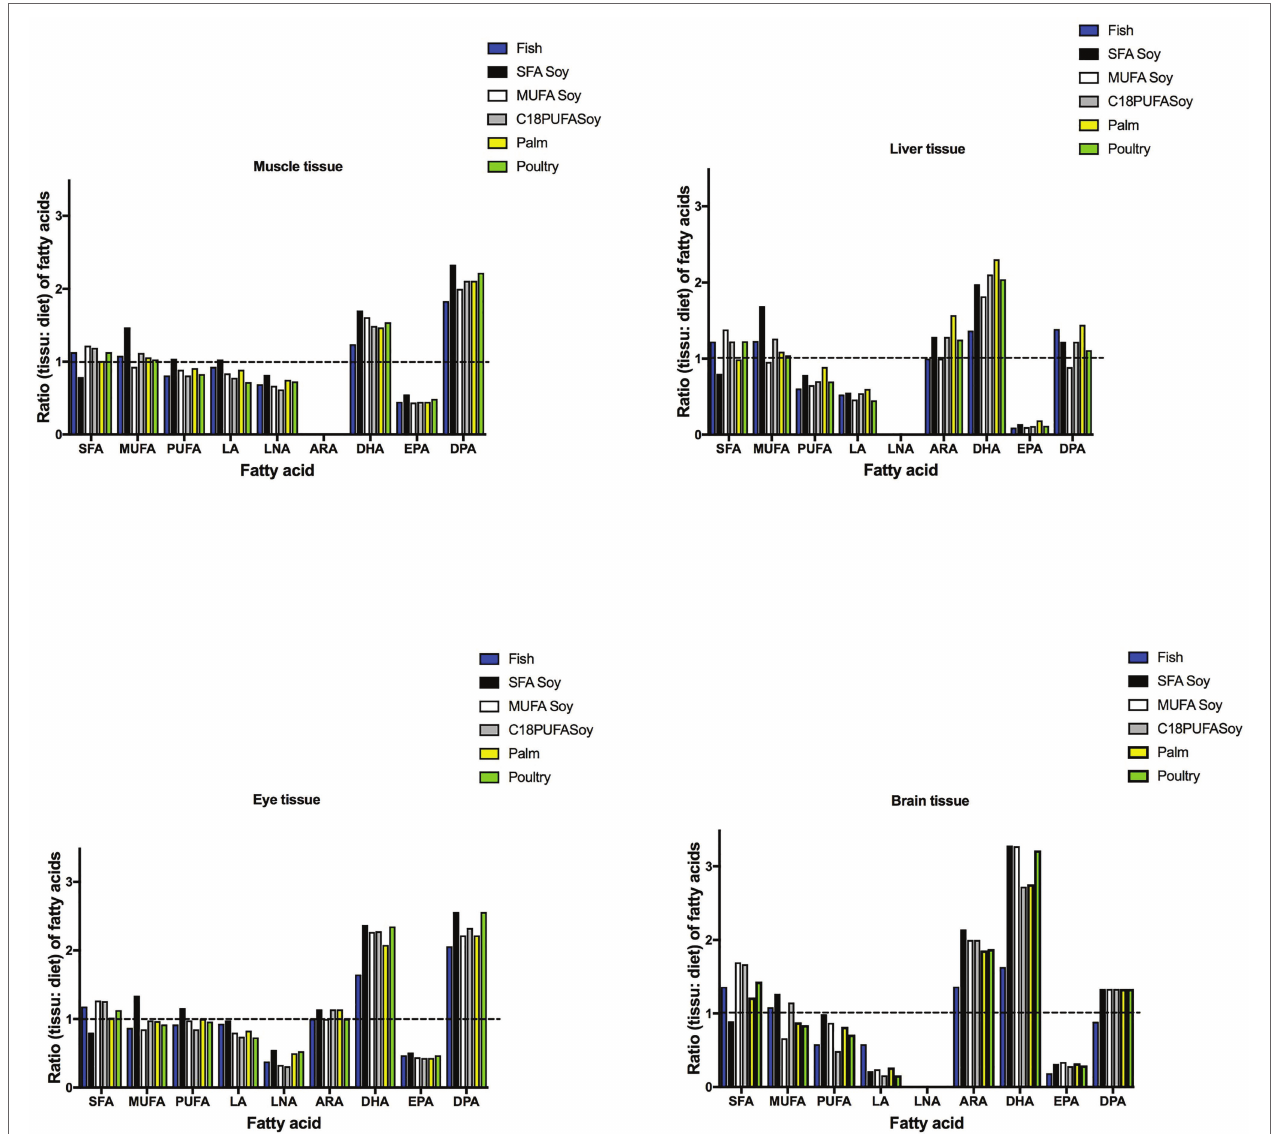
FIGURE 3 | Ratio (tissue: diet) of fatty acids in juvenile Florida pompano ( T . carolinus ) muscle, liver, eye, and brain tissue (44 g average weight). Diet treatments consisted of a diet containing menhaden fish oil (Fish), SFA-enriched soybean oil (SFA Soy), MUFA-enriched soybean oil (MUFA Soy), 25:75 blends of fish oil and standard soybean oil (C18 PUFA Soy), palm oil (Palm), or poultry fat (Poultry; Rombenso et al., 2016). The dashed lines (ratio = 1) indicate equal amounts of fatty acids in the juveniles and in the diet. LA, linoleic acid; LNA, linolenic acid; ARA, arachidonic acid; DHA, docosahexaenoic acid; EPA, eicosapentaenoic acid; SFA, saturated fatty acids; MUFA, monounsaturated fatty acids; and PUFA, polyunsaturated fatty